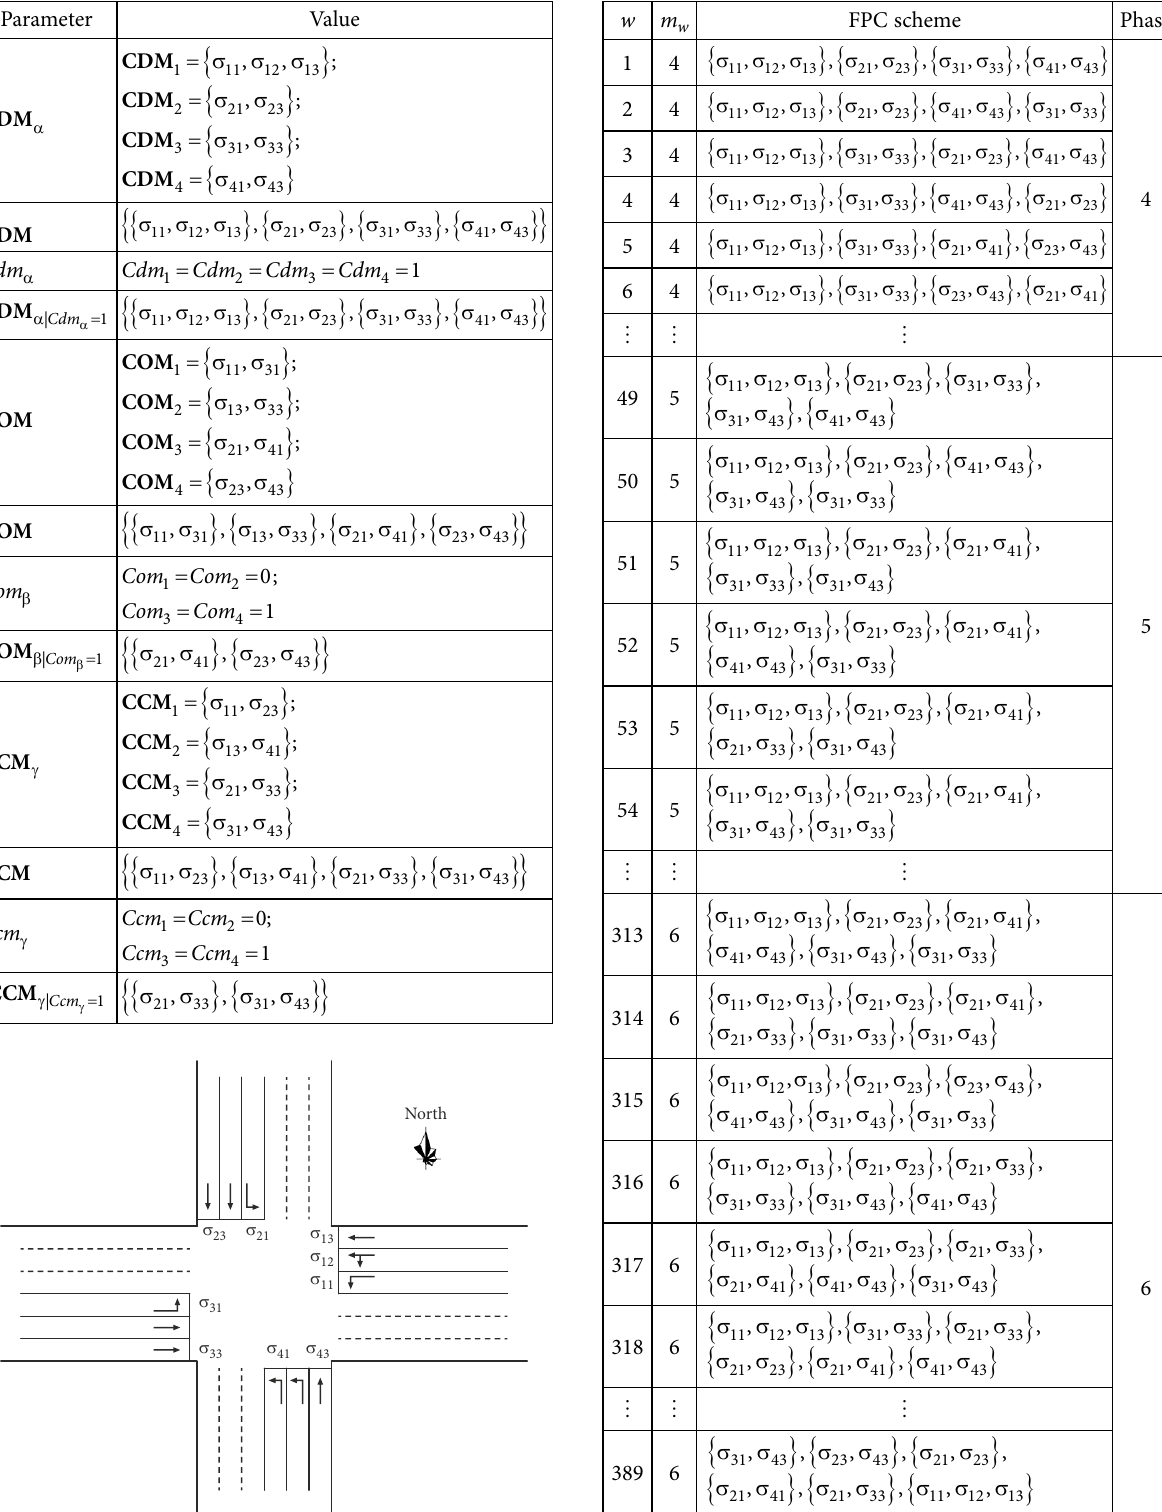
Table 4. Values of movement correlation parameters